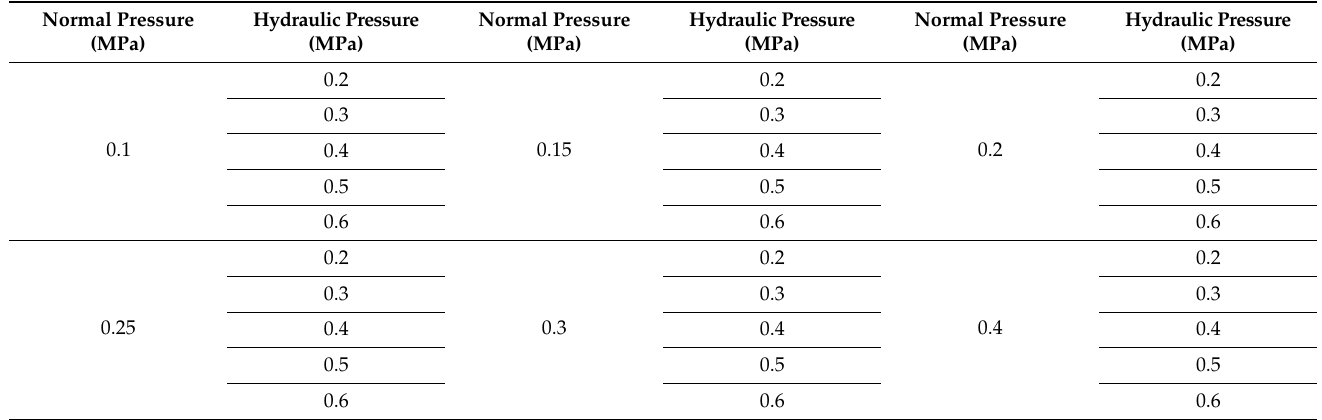
Table 3. Test scheme of fluid seepage in rough fractures under different normal pressures and water pressures.